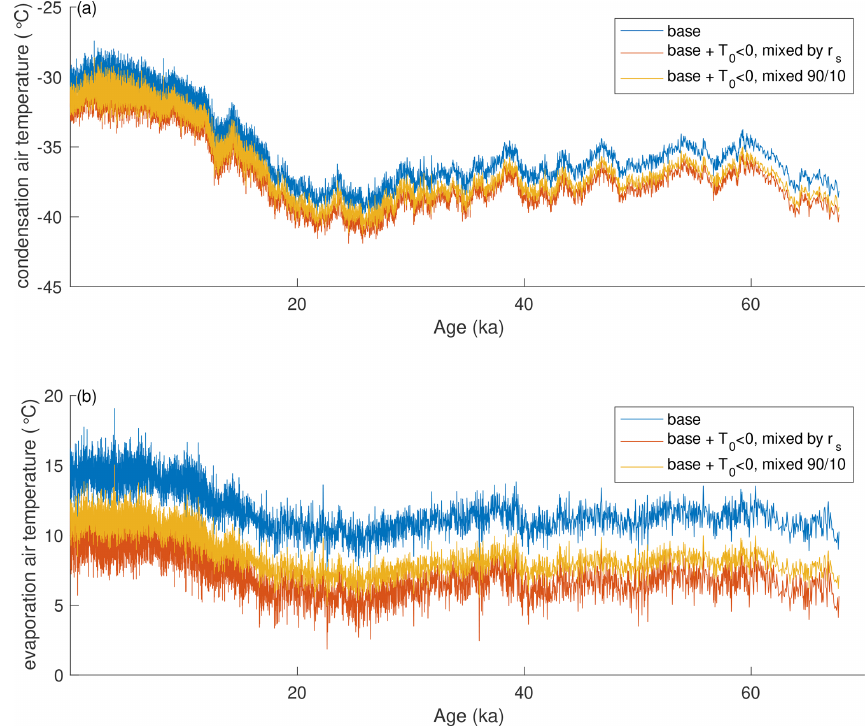
Figure A30. Temperature reconstructions for WDC accounting for below-zero evaporation air temperatures. (a) Reconstructions of T c under base conditions (blue; no contribution from T 0 < 0 ◦ C), with the contribution from T 0 < 0 ◦ C weighted by the final r s (red) and with a 90% contribution from T 0 > 0 ◦ C as well as 10% from T 0 < 0 ◦ C (gold). (b) Same as in (a) but for reconstructions of T 0